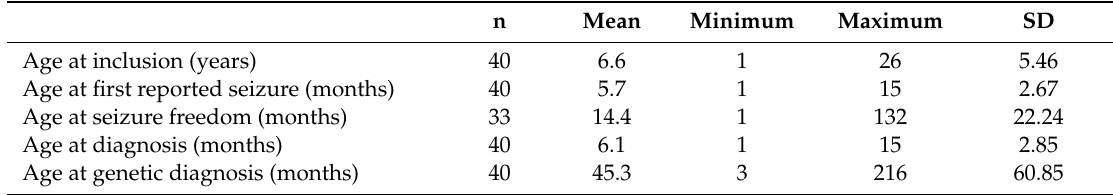
Table 1. Characteristics of 41 children with infantile epilepsy and genetic variation of PRRT2 (core cohort).